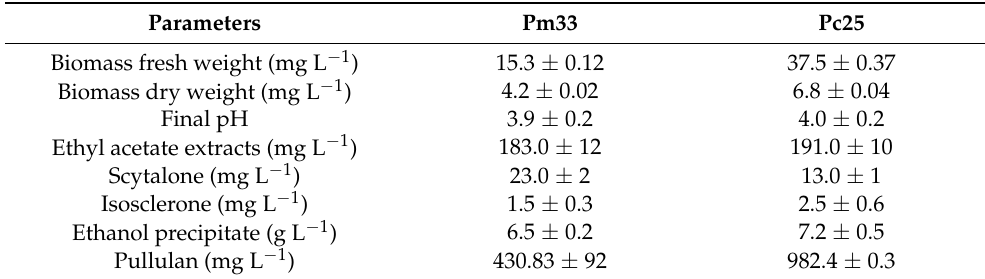
Table 1. Biomass, recorded as fresh and dry weight, final pH values and yield of secondary me- tabolites produced by Phaeoacremonium minimum (Pm33) and Phaeomoniella chlamydospora (Pc25) grown 28 days on Czapek modified medium at 25 ± 2 °C in the dark. 1